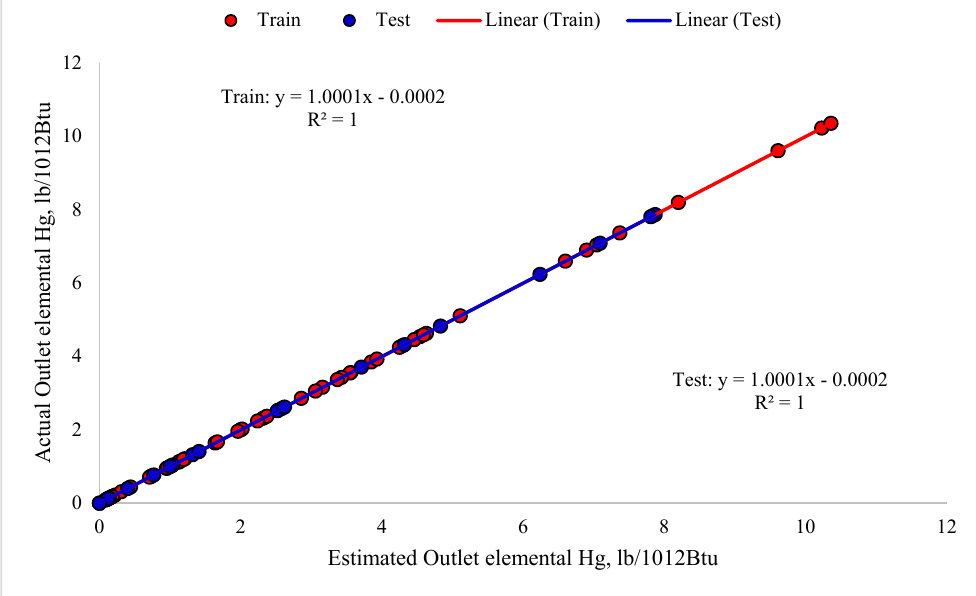
Table 1. Statistical analysis of the model for all phases.